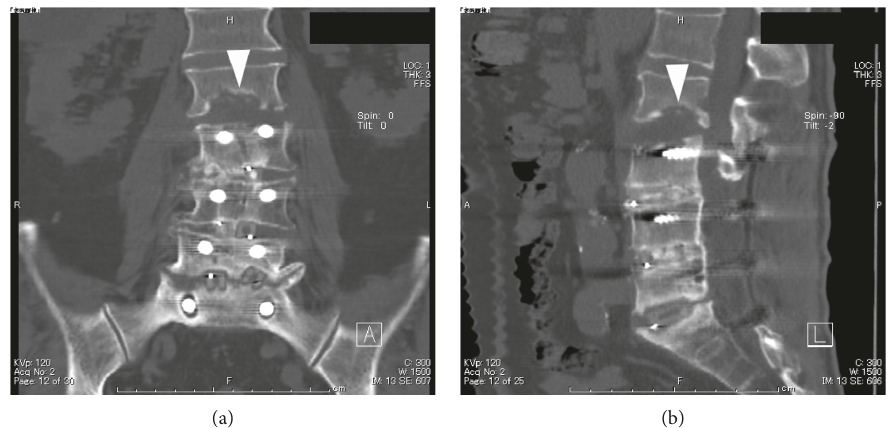
Figure 1: Case 1: coronal (a) and sagittal (b) CT scans showed erosion of endplates at the L2-3 level (arrowhead).